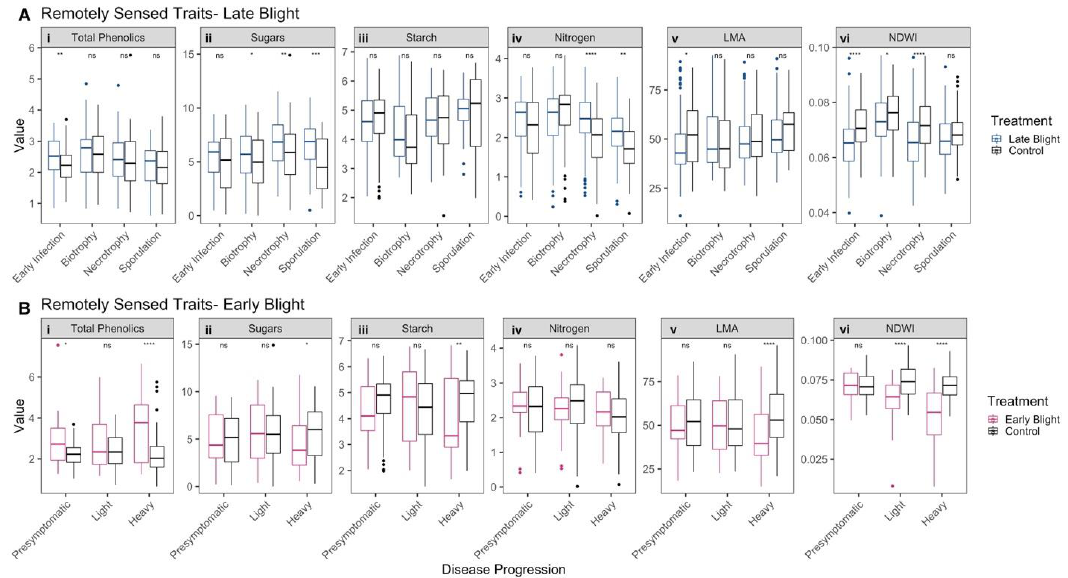
Figure 5. Non-destructively sensed physiological and biochemical traits indices difference between diseased and healthy leaves for ( A ) late blight and ( B ) early blight binned by respective disease time stages. Y -axis scales: ( A ( i ), B ( i )) total phenolics concentration, percent dry matter, ( A ( ii ), B ( ii )) total sugars concentration, percent dry matter, ( A ( iii ), B ( iii )) total starch concentration, percent dry matter, ( A ( iv ), B ( iv )) nitrogen concentration, percent dry matter, ( A ( v ), B ( v )) leaf mass per area (LMA), gram/meters 2 , ( A ( vi ), B ( vi )) normalized difference water index (NDWI).